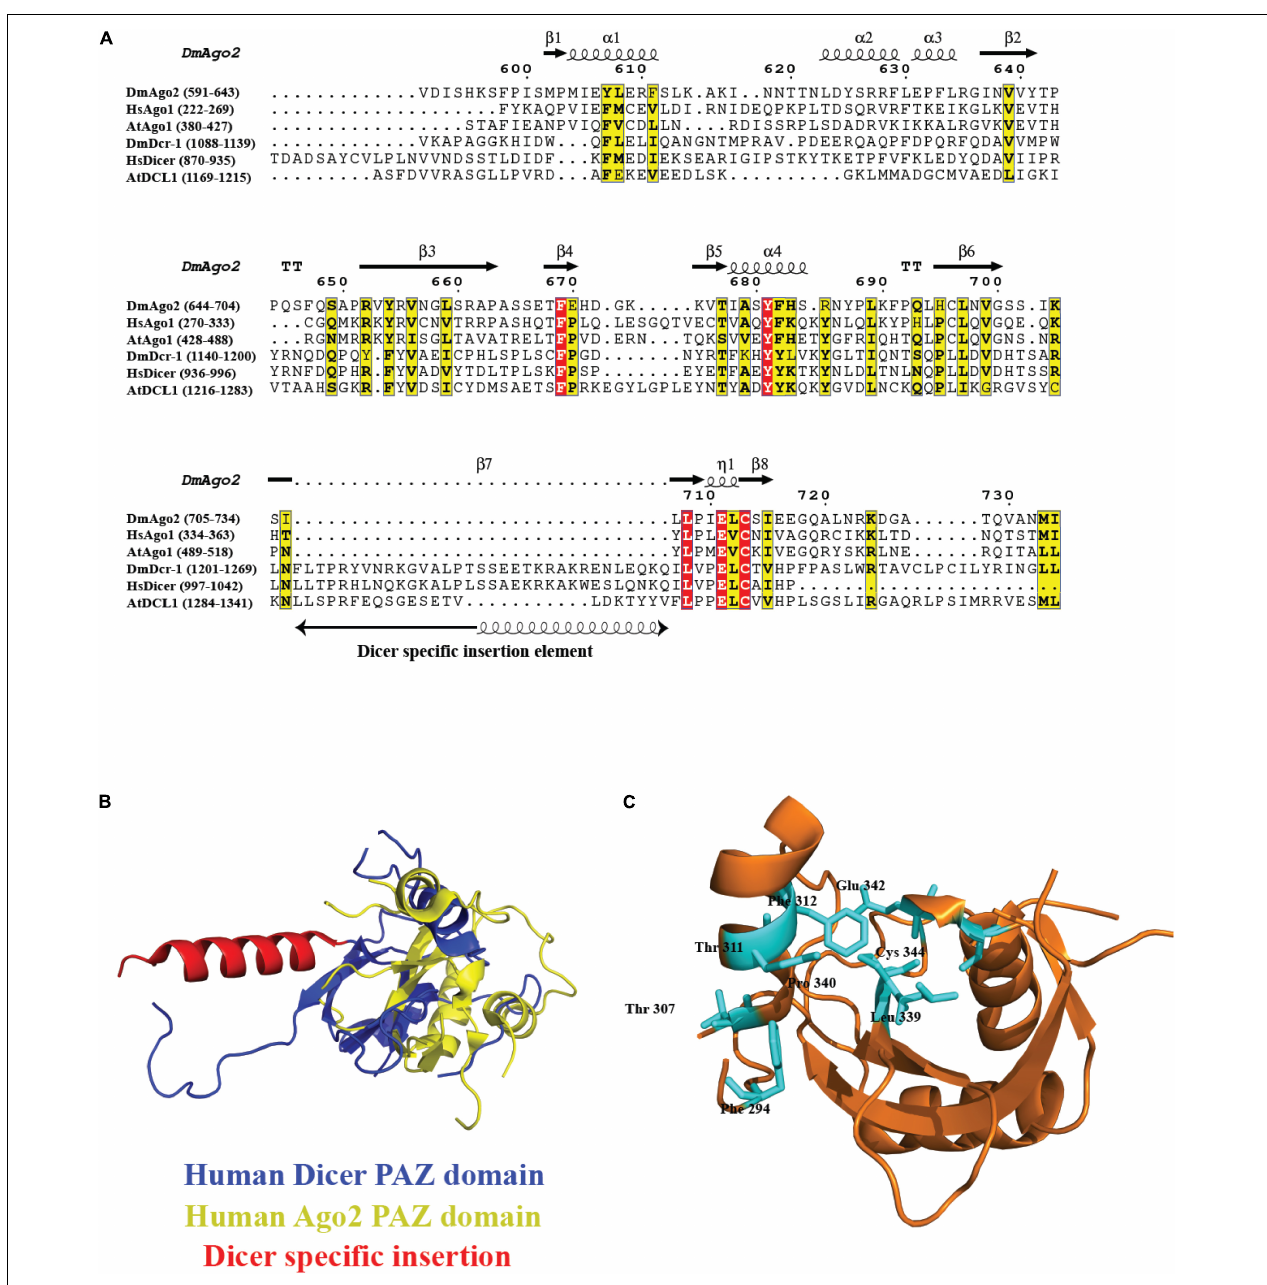
FIGURE 6 | Conservation of PAZ domain in the Ago and Dicer family. (A) Sequence alignment of the PAZ domain present in different organisms shows several key residues involved in RNA recognition are conserved. In the case of PAZ in Dicer proteins, there is an extra insertion of a helix. (B) Overlay of Hs Dcr PAZ domain (PDB code: 4NGD) and Hs Ago2 PAZ domain (PDB code: 4W5O). The overall fold is conserved with the additional helix protruding out of the main fold. (C) The ribbon diagram of the PAZ domain from Hs Ago2 shows invariant residues highlighted in cyan present in all the